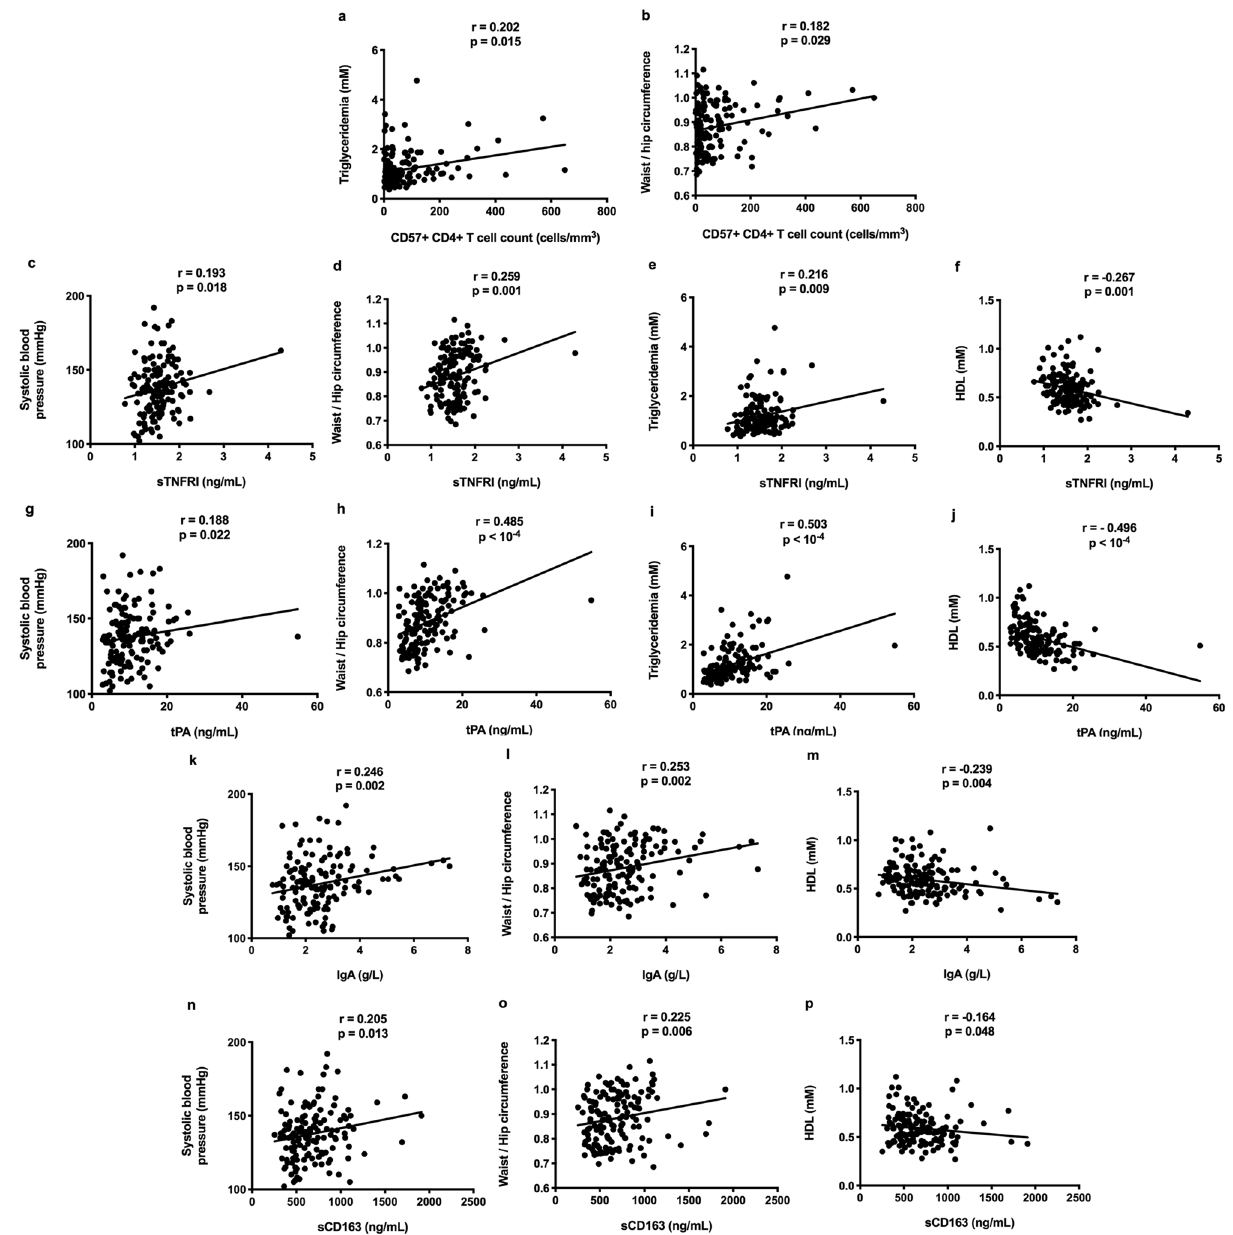
Figure 6. Links between various activation markers and markers of metabolic syndrome in the whole